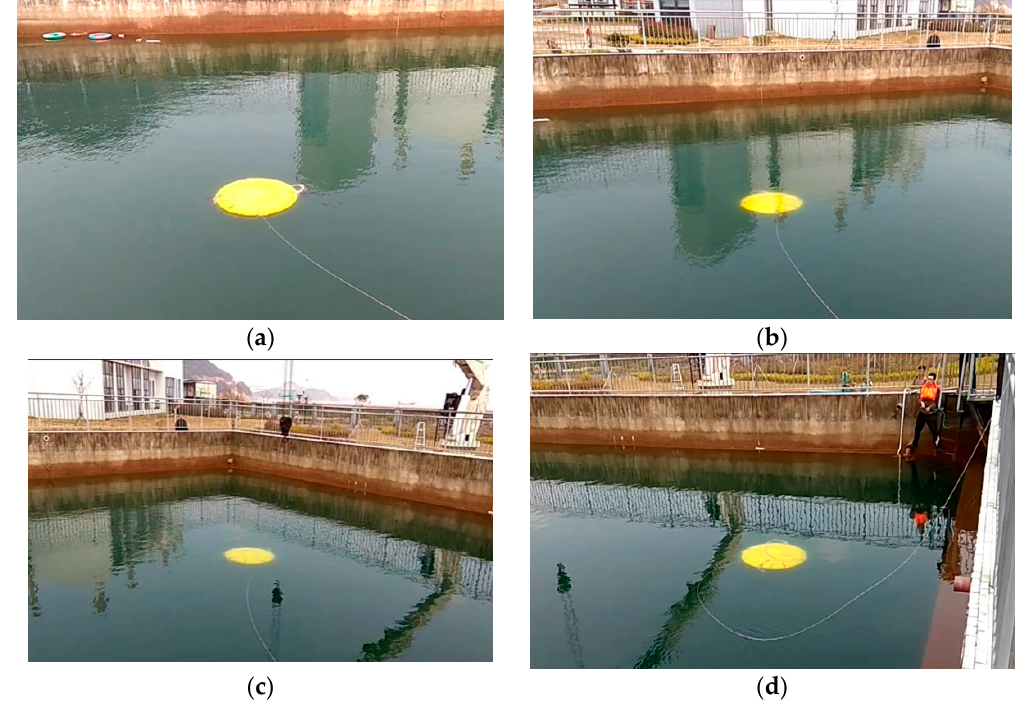
Figure 14. Photo of the quadrangle motion experiment in the horizontal plane: ( a ) the initial state of the quadrangle motion; ( b ) the first turn of quadrilateral motion; ( c ) the second turn of quadrilateral motion; ( d ) the third turn of quadrilateral motion.